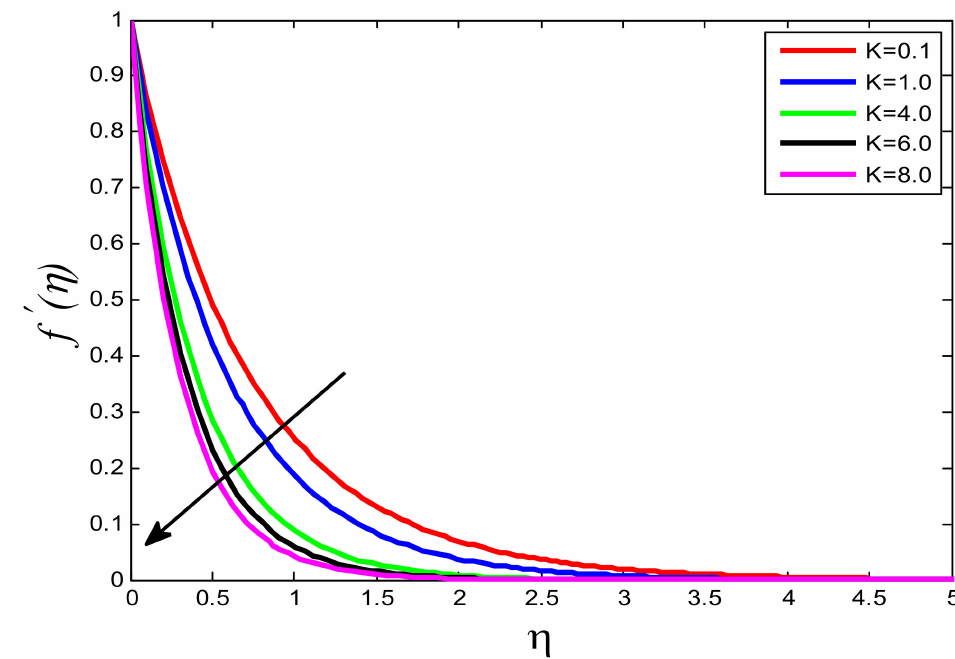
Figure 10. Influence of K on f (cid:48) ( η ) .